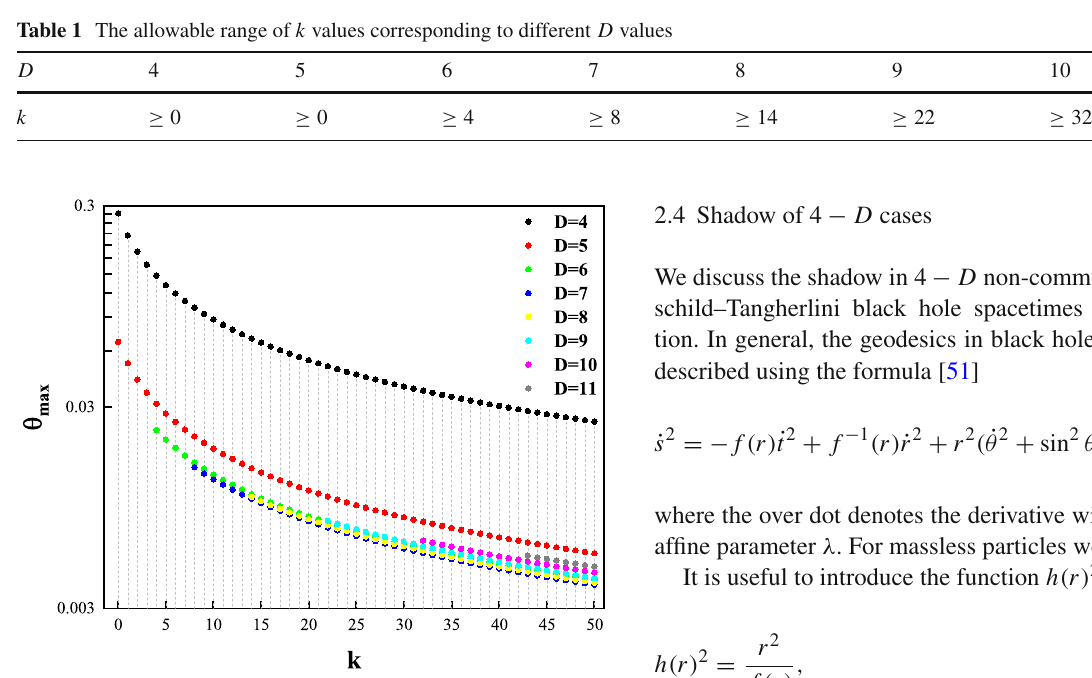
Fig. 1 θ max values for different k and D values